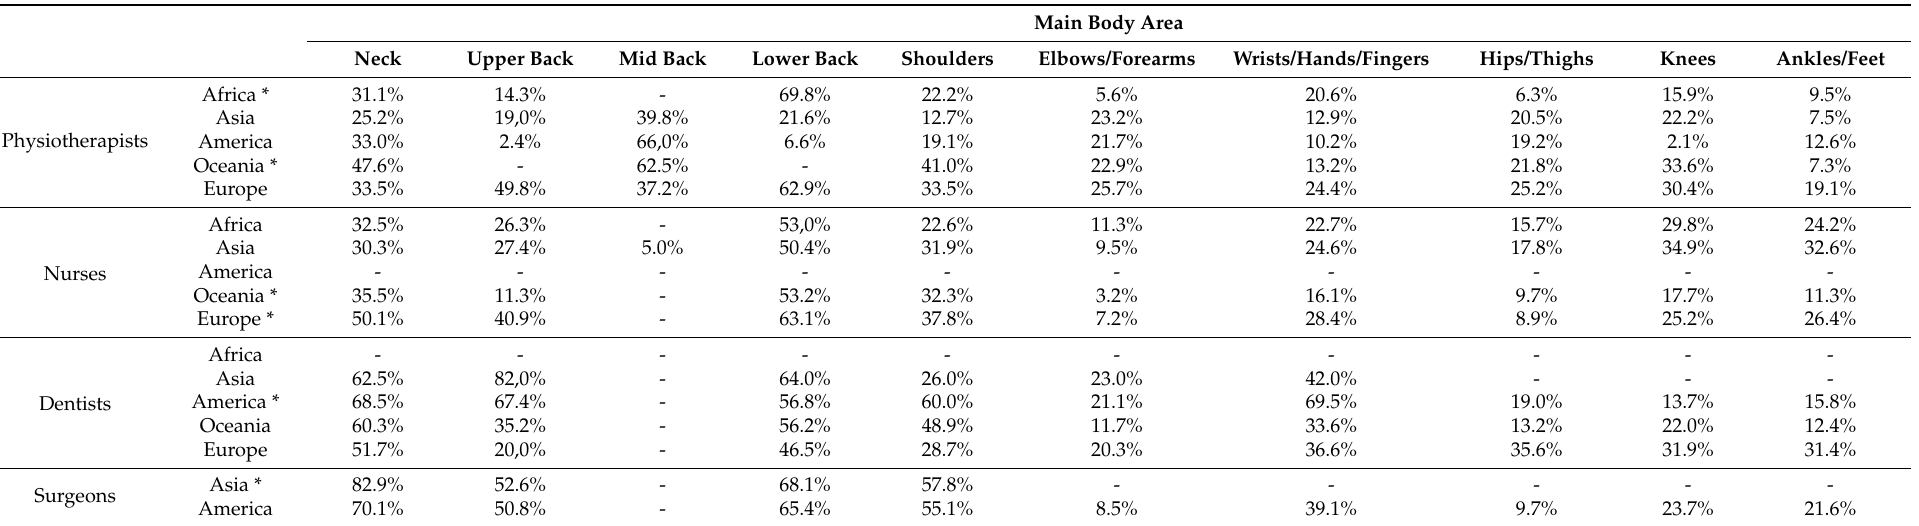
Table 4. MSD prevalence by body area and healthcare profession, summarized by